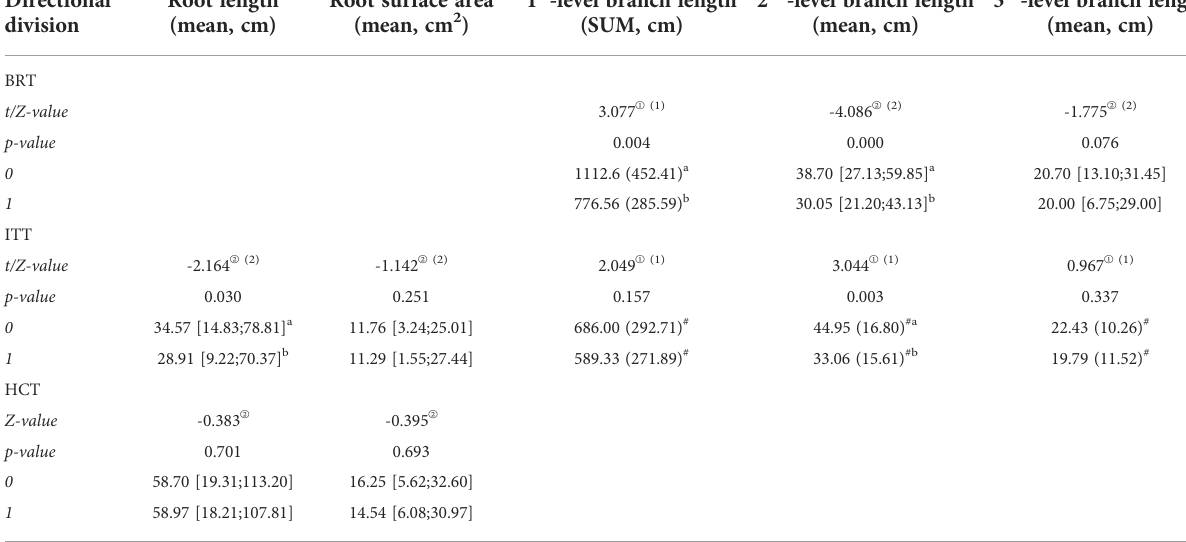
TABLE 2 Directional comparisons of root and branch variables in response to the asymmetric treatments. Directional